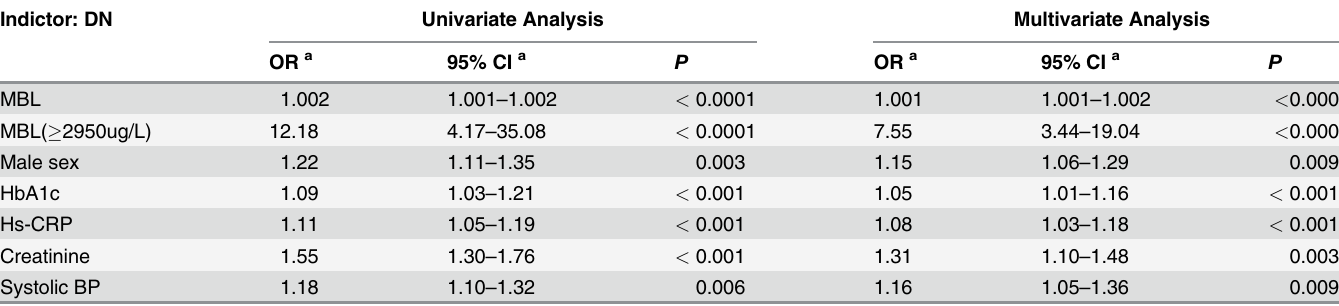
Table 2. Univariate and multivariate logistic regression analysis for DN Indictor: DN Univariate Analysis Multivariate